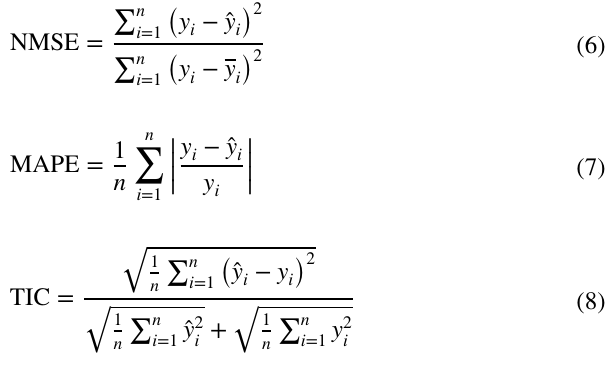
Table 2 R 2 of various algorithms using different parameter combinations